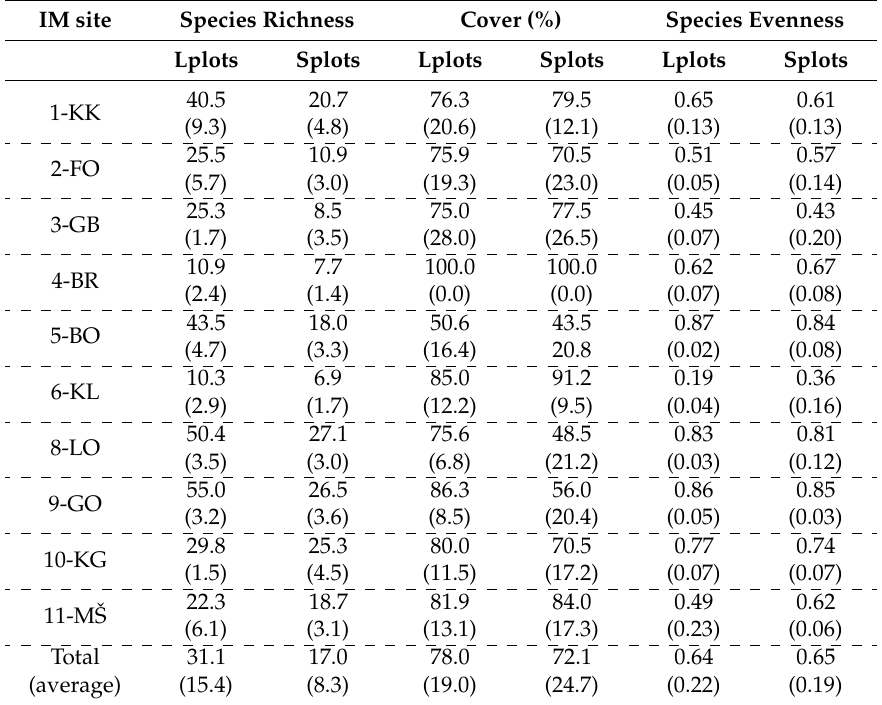
(Figure 2). For Splots, PC1 accounted for 60.5%, PC2 for 19.2% and PC3 for 17.3% of the total variation (Figure S1). In both cases, PC1 was negatively correlated with N (Pearson’s correlation coe ffi cient r = − 0.549 for Lplots, r = − 0.562 for Splots) and R (Lplots: − 0.541, Splots: − 0.554) and positively associated with L (Lplots: 0.514, Splots: 0.516). The second axis, PC2, showed a significant positive relation to altitudinal gradient (Lplots: 0.966, Splots: 0.939), while PC3 was strongly correlated with F (Lplots: − 0.923, Splots: 0.948) (Figure 2, Figure